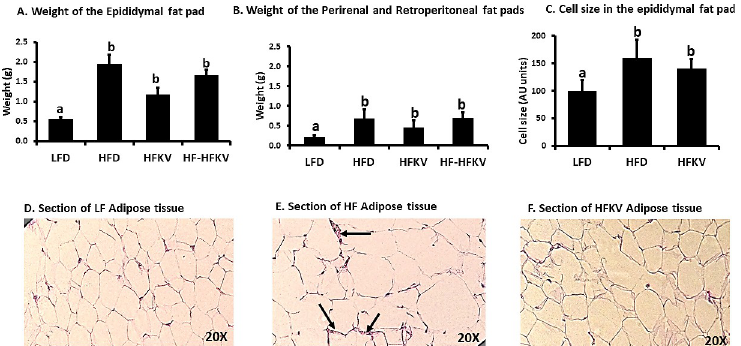
Fig 2. Supplementation with kale vegetable did not lower fat accumulation but reduced inflammatory markers in adipose tissue. (A and B). The weight of the epididymal fat pad and combined weight of perirenal and retroperitoneal fat pads were higher in HFD compared to LFD fed group (P < 0.05; n = 9). Supplementing the HFD diet with kale from beginning of the study or after 6 weeks of HFD feeding did not lower fat pad weights compared to the HFD diet (P > 0.05; n = 9) after ANOVA. (C). Cell size of epididymal fat on H and E stained sections was determined by measuring cross-sectional width of the cells at 40X magnification and standardizing LFD group size to 100. HFD diet increased cell size. The cell size of HFD and HFKV was not different (P > 0.05; n = 9) after ANOVA. (D-F). H and E stained sections of the epididymal fat pad showed that LFD group had smaller adipocytes in size with no markers of inflammation visible. The HFD sections showed larger adipocytes and presence of crown like structures the markers of inflammation (shown by arrow). The HFKV sections showed large adipocytes but no crown like structures. ‘a’ Different letters indicate significant differences after ANOVA at P < 0.05.